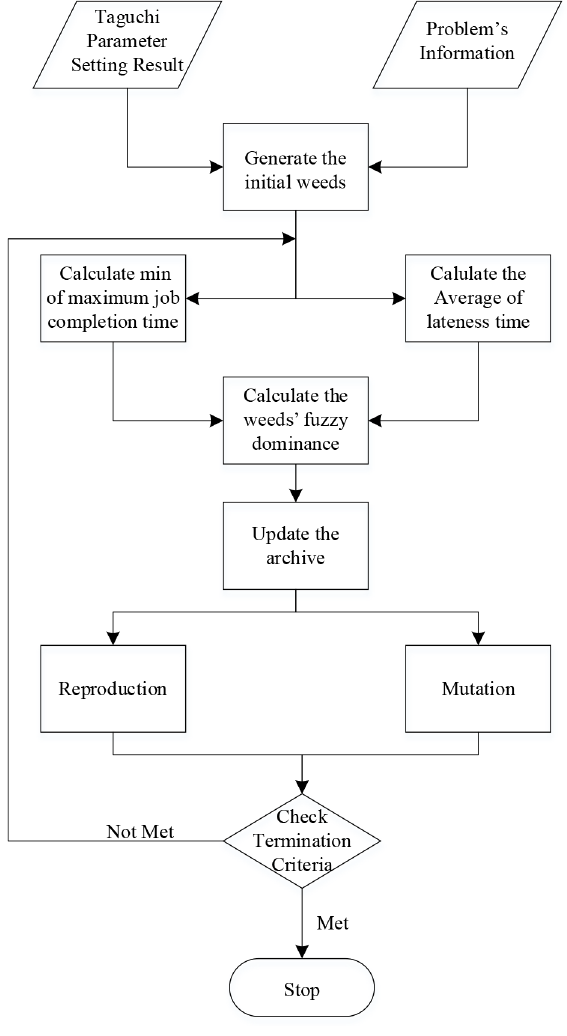
Figure 9. DMOIWO